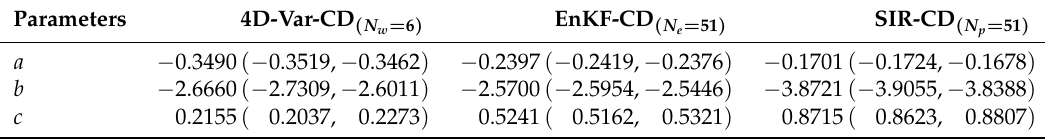
Table 2. Fitting parameters (with their 95% (sample) confidence interval) for the threshold